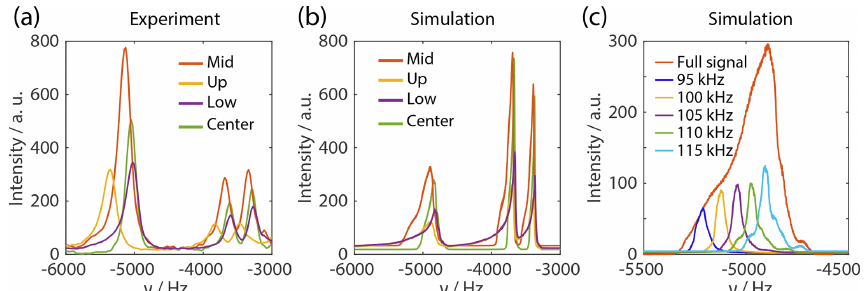
Figure 8. (a) Experimental spectra of natural abundance glycine using FSLG decoupling in the indirect dimension. The packing schemes correspond to the adamantane samples. (b) Simulated proton spectra of natural abundance glycine using an eight-spin system as input. The different contributions of the rotor to the total spectra are shown in different colors that match Fig. S7. The rf-field resolution was 500Hz using the rf profiles measured on adamantane. The frequency axis is not an absolute axis and only the spacing between the peaks is correct. The line width and relative intensities of the NH + peaks are comparable. The single outlier is the relative intensity of the middle third compared 3 to the center packed rotor. However, this might be due to slightly different packing in the adamantane and the glycine. (a) Simulated NH + 3 peak of the sample restricted to the middle third showing the contribution to the total line width of the weighted lines of different rf-field amplitudes. An rf-field range of 2kHz was used for each of the rf-field amplitudes generating a line width of around 30Hz. The total line width is dominated by the isotropic chemical-shift distribution due to the variation in the scaling